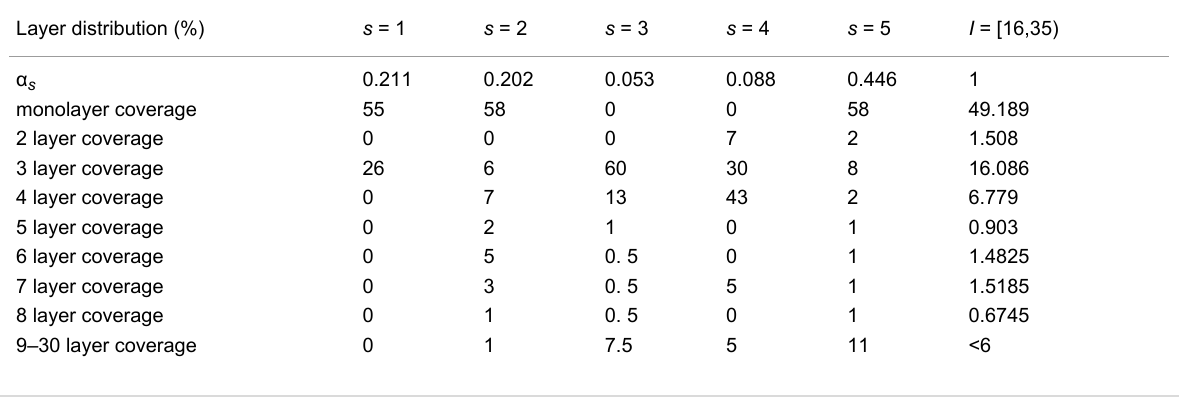
Table 5: Coverage of j -layer graphene sample GAE1 regions by the model in Equation 3. Layer distribution (%)